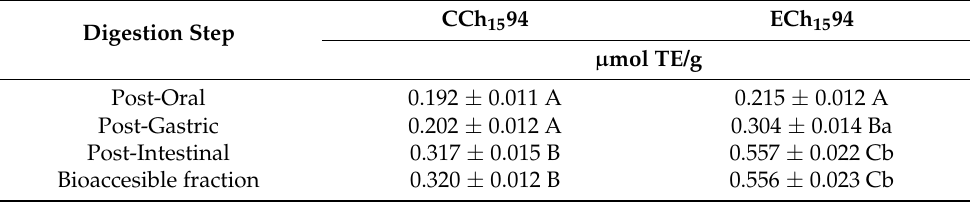
Table 5. Antioxidant activity of in vitro digested cheeses measured by ABTS